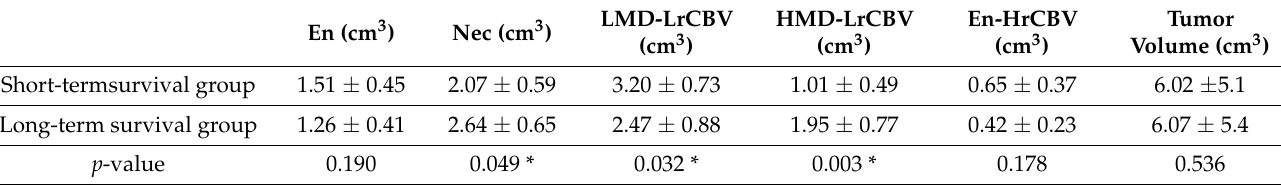
Table 3. Relative volume of ROIs in different groups.